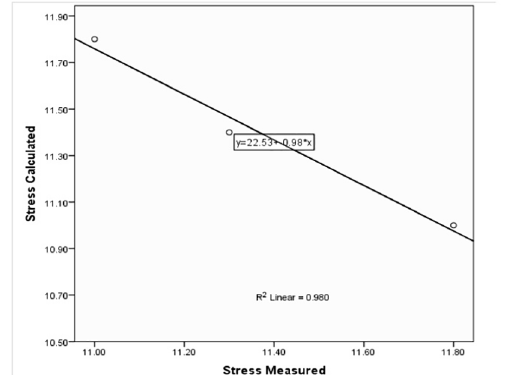
Figure 13. Stress vs. Stress Measured